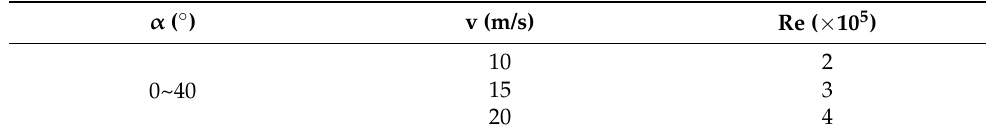
Figure 11. Lift coefficient and moment coefficient of static airfoil under forward-blowing and re- verse-blowing. By analyzing Figure 8, it can be found that there are some differences between the forward and reverse-blowing; the moment coefficient is clearly different. There are five main findings: